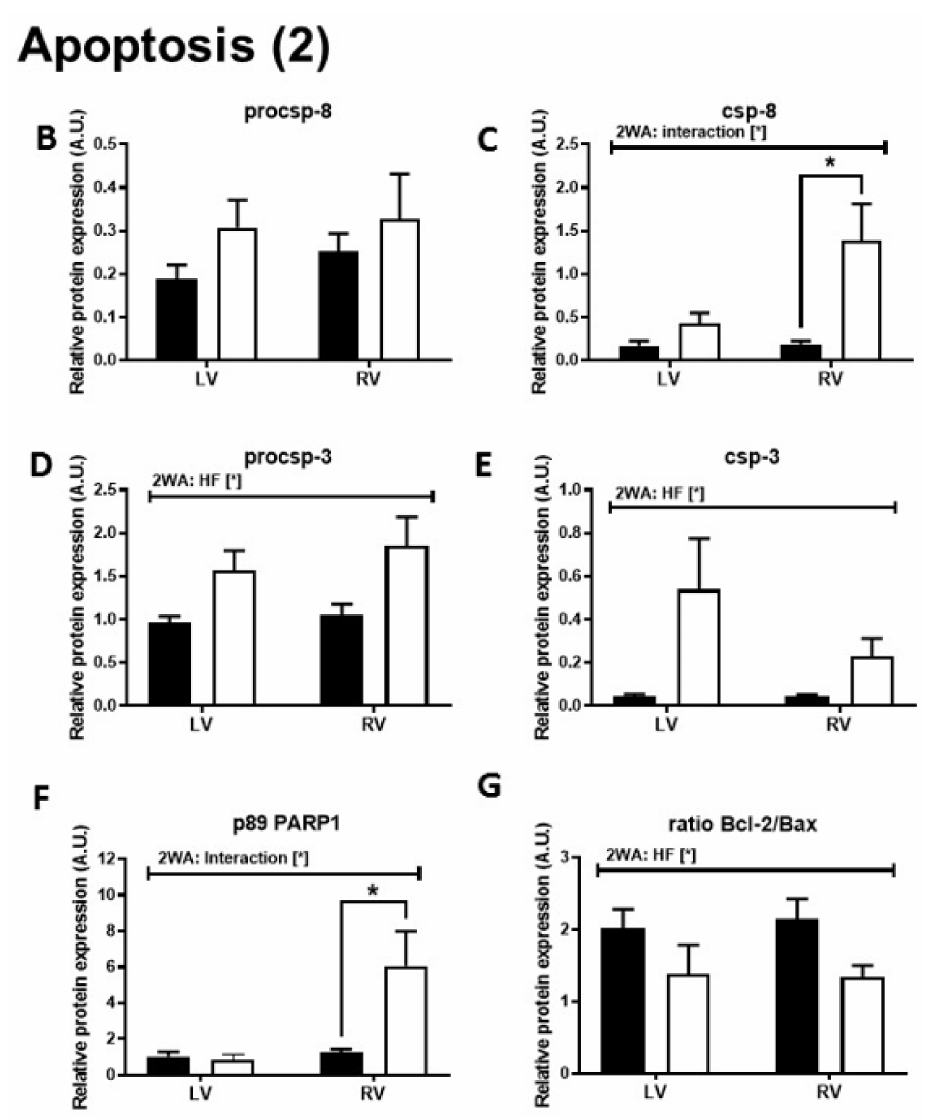
Figure 4. Analysis of apoptotic signaling in the left and right ventricle of rat hearts. ( A ) representative immunoblots and total protein staining; ( B – G ) Immunoblot quantification of procsp-8, csp-8, procsp-3, csp-3, p89 PARP1, ratio Bcl-2 / Bax in Sham—sham-operated group; HF—group with post-myocardial infarction heart failure; LV—left ventricle; RV—right ventricle. Data are presented as mean ± SEM; n = 6–9 per group; 2WA—2-way ANOVA; “HF” factor—presence of heart failure; “V” factor—heart ventricle; “Interaction” of 2 factors. * p < 0.05 vs.